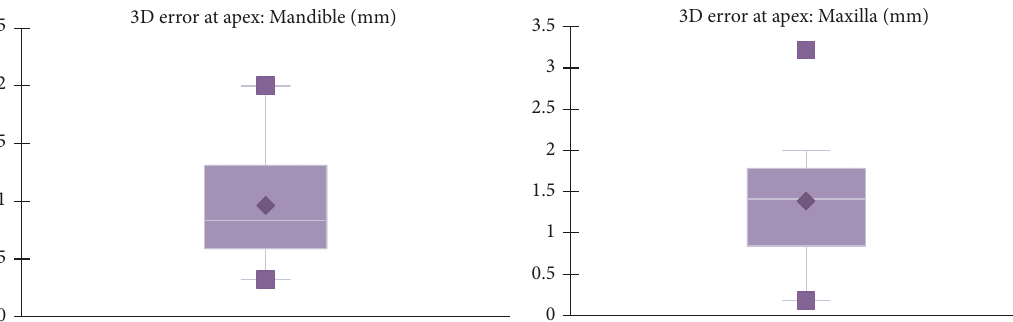
Figure 10: Mean 3D error at the apex measured at the center of the implant in mandible and